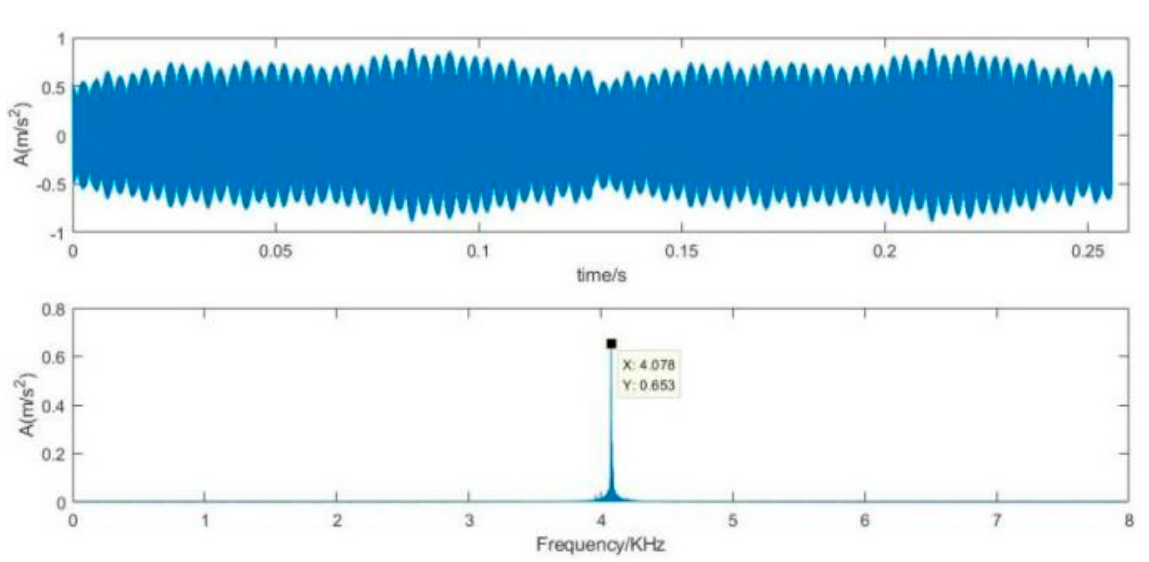
Figure 7. Denoised signal by reconstructing components of SVD-DS.